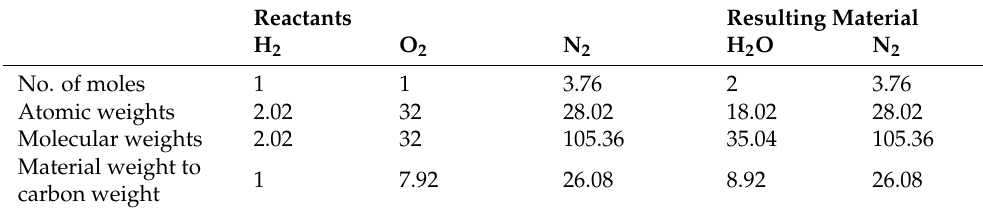
Table 4. The chemical properties of hydrogen interacting with